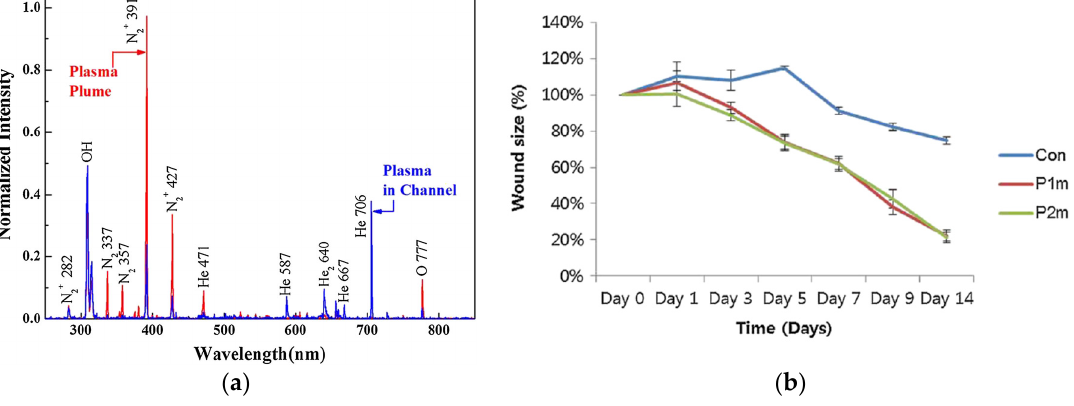
Figure 6. ( a ) Optical emission spectra corresponding to a 3 × 3 array microplasma jet measured in the channel and outside in open air. ( b ) Evaluation of burn closure times in rats after plasma jet treatment for 1 min (P1m) and 2 min (P2m) compared to a control sample (Con). Reprinted/adapted with permission from Ref. [41]. Copyright 2015, John Wiley & Sons, Ltd.